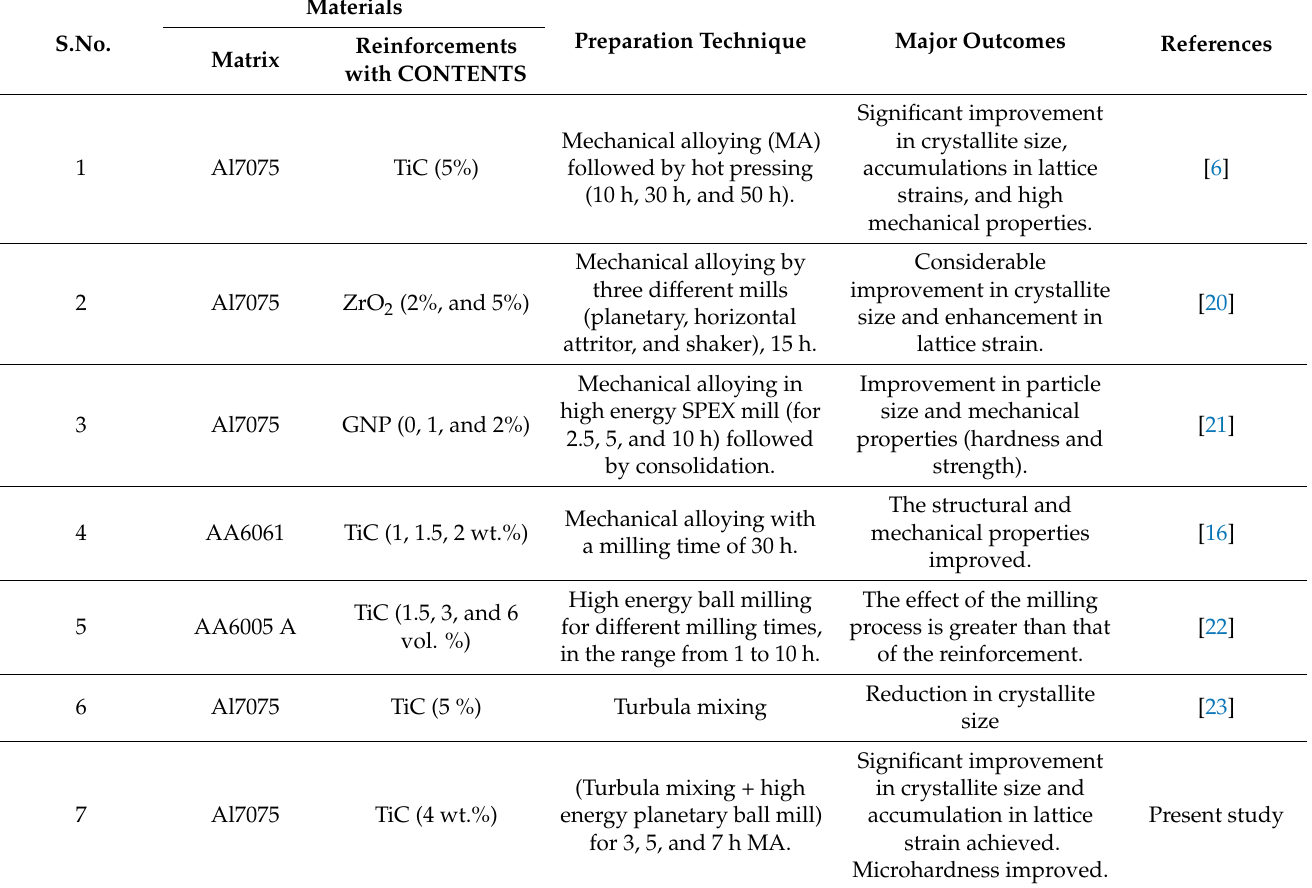
Table 1. Aluminum-based composites produced by mechanical